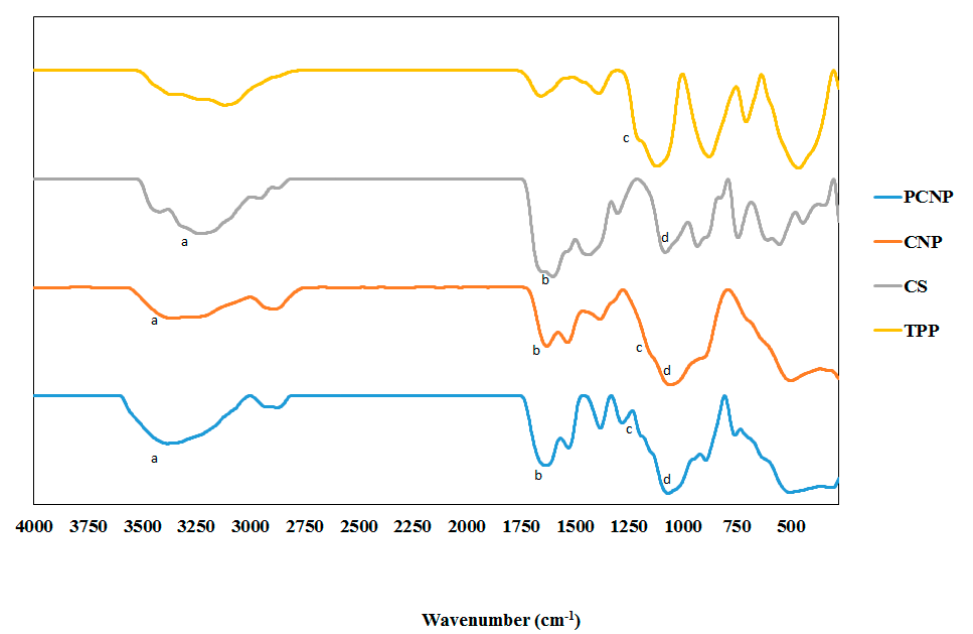
Figure 7. FTIR spectra of CS, TPP, CNP and PCNP have shown some of the important functional group in comparison. The functional groups are labeled as ( a ) amine group, ( b ) amine II group, ( c ) inorganic phosphate group and ( d ) C–O–C bond.